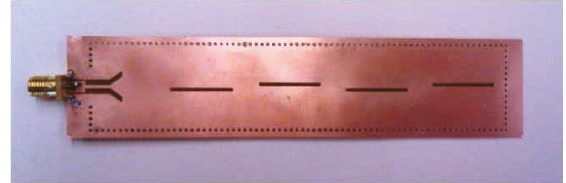
Figure 14: Implementation of SIW antenna on plastic substrate [70].